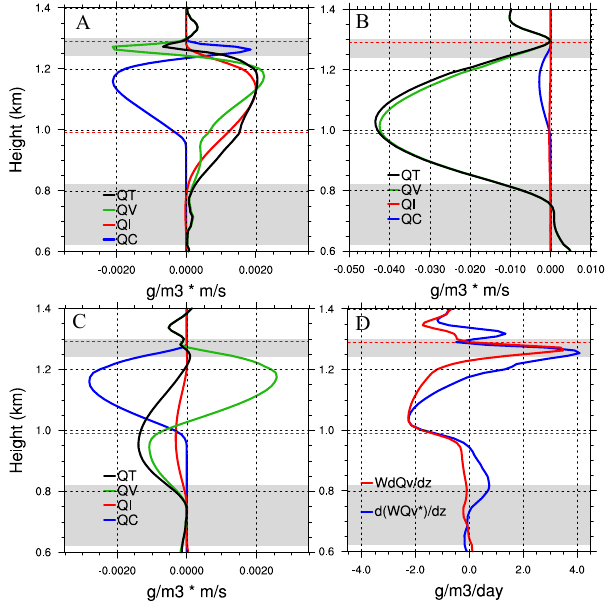
Fig. 15. Horizontally and temporally averaged vertical water con- tent fluxes, in units of gm − 3 m s − 1 . Entrainment zones indicated with gray shading. (A) Eddy fluxes. (B) Mean fluxes. (C) Mean fluxes as in (B) except mean water vapor vertically averaged be- tween 0.7–1.4km is removed before calculating mean water vapor flux. (D) Vertical derivative of modified mean water vapor flux (WQv ∗ ) from (C) compared to water vapor tendency due to ad- vection by mean vertical velocity (WM in Fig. 14b). Cloud layer top and base indicated by red dashed